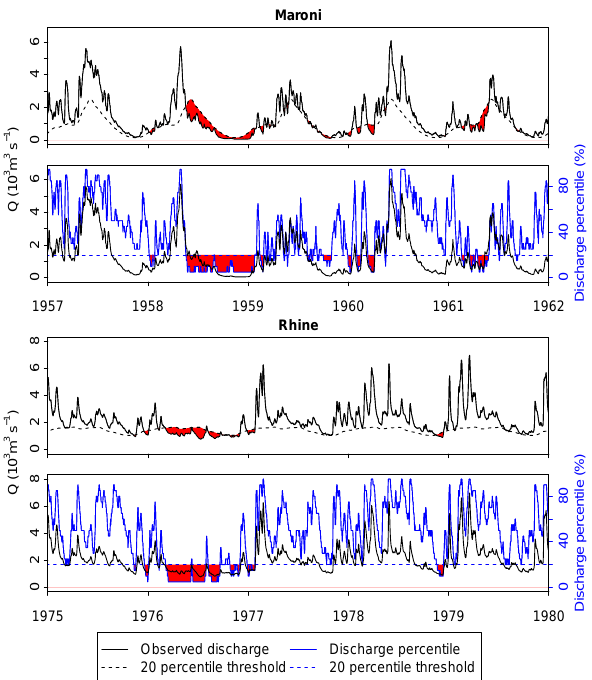
Fig. 7. Drought events (indicated in red) identified by the different methods for the Maroni and Rhine Rivers. Upper panel: TLM for Maroni River; second panel: combined method for Maroni River; third panel: TLM for Rhine River; fourth panel: combined method Rhine River. In all panels, the observed discharges are given (black line) and the threshold values (here the 20th percentile, dashed lines). From the observed discharge, percentile values for each day are calculated (blue line).